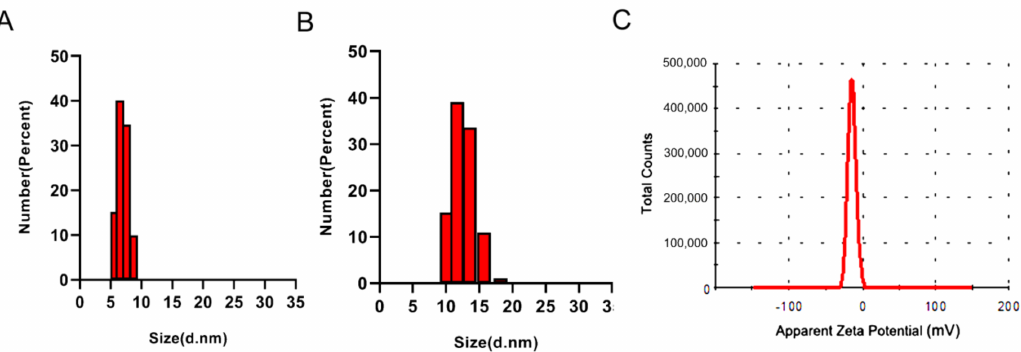
Figure 3. Characterization of PD-L1 aptamers and Apt-HJ by dynamic light scattering (DLS). ( A ) Size distributions of free PD-L1 aptamers. ( B ) Size distribution of Apt-HJ. ( C ) Zeta potential distribution of